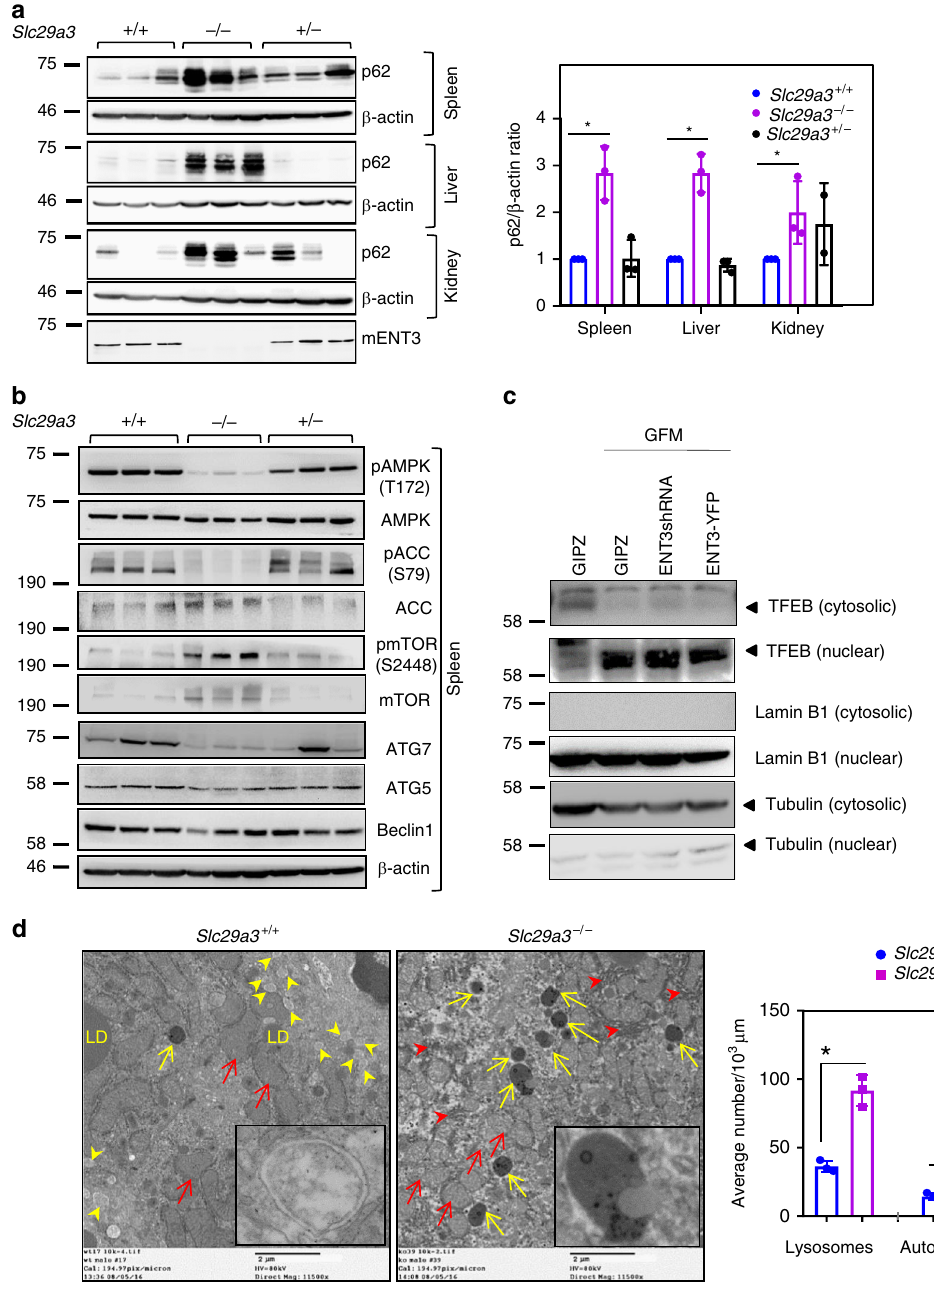
Fig. 7 Autophagy perturbation in Slc29a3 − / − adult mouse tissues. Immunoblotting analysis (left) and quanti fi cation (right) of lysates prepared from the Slc29a3 − / − spleen, liver, and kidney showing the accumulation of p62 compared with that in Slc29a3 + / + tissues ( a ). Immunoblotting analysis of the AMPK-mTOR-ULK axis and core autophagy genes in Slc29a3 + / + , Slc29a3 − / − and Slc29a3 + / − splenic lysates ( b ). HEK293 cells were transfected with control or hENT3YFP plasmids, and the cytosolic and nuclear fractions were isolated and examined for alterations in the TFEB levels using immunoblotting analysis. No signi fi cant changes in the TFEB levels were identi fi ed in the presence or absence of hENT3. Lamin B1 was used as a nuclear marker, and tubulin was used as a cytosolic marker. β -Actin served as the loading control ( c ). TEM analysis (left) and quanti fi cation (right; ( n = 3, mean ± SEM)) of lysosomes (yellow arrow) and autophagosomes (yellow arrowhead) in Slc29a3 + / + and Slc29a3 − / − mouse livers. Insets show representative lysosome and autophagosome structure(s) in Slc29a3 + / + and Slc29a3 − / − livers, respectively. Increased proliferation of mitochondria (red arrow) and ER (red arrowhead) in Slc29a3 − / − livers. LD, lipid droplets; Scale bars: 2 μ m ( d ). Statistical analyses were performed using two-tailed Student ’ s t- test. * P < 0.05. Source data are provided as a Source Data fi